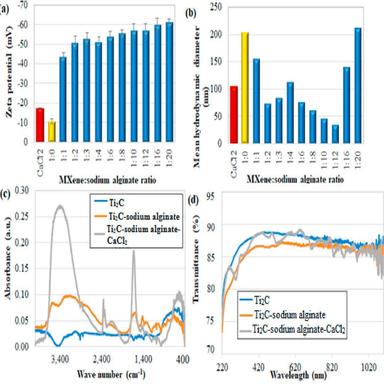
Colloidal stability characterization of 2D Ti2C particles in the presence of sodium alginate and CaCl2 for distilled water-based dispersions, involving (a) zeta potential,(b) DLS studies. Physicochemical characterization of 2D Ti2C particles in the presence of sodium alginate and CaCl2 for distilled water-based dispersions, analyzed by (c) FTIR and (d) UV–Vis.